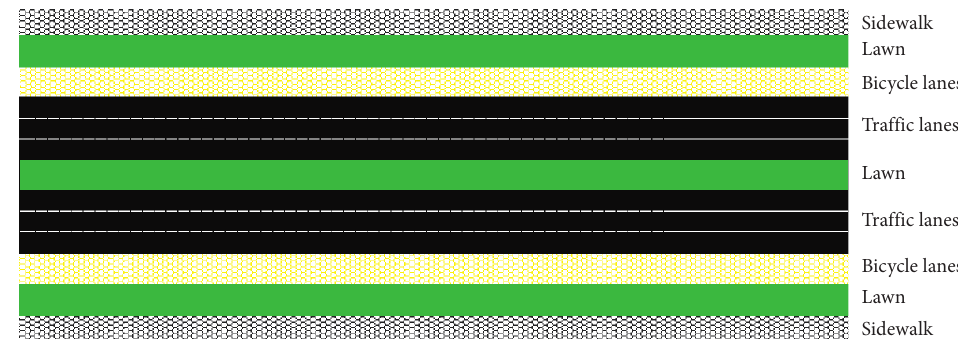
Figure 1: Pavement lane distribution.